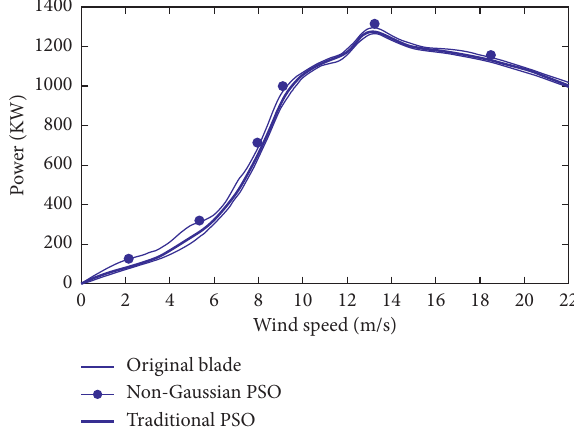
Figure 4: Comparison of output power before and after optimization. Table 2: Comparison of computation residuals by different